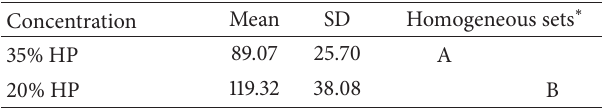
Table 2: Results of Tukey’s test for the hydrogen peroxide concen- tration factor.